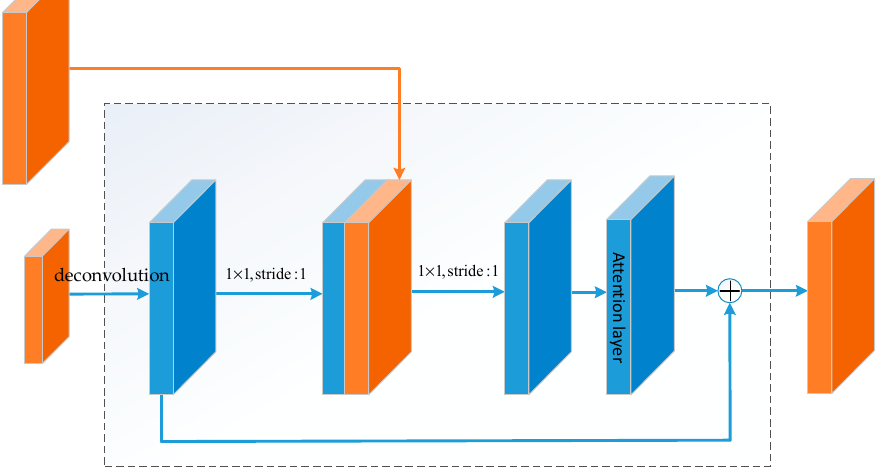
Figure 3. Schematic diagram of up-sampling structure in hourglass structure incorporating attention mechanism.